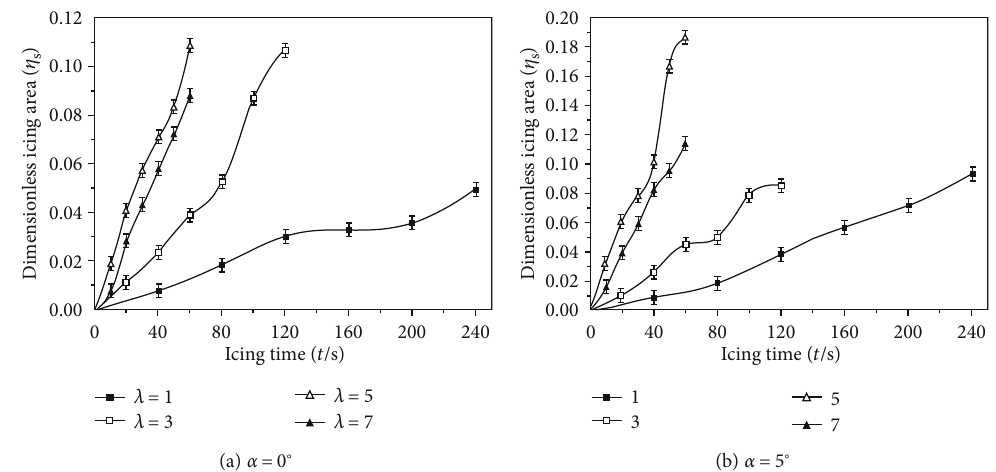
Figure 19: Dimensionless icing areas under rotating states.